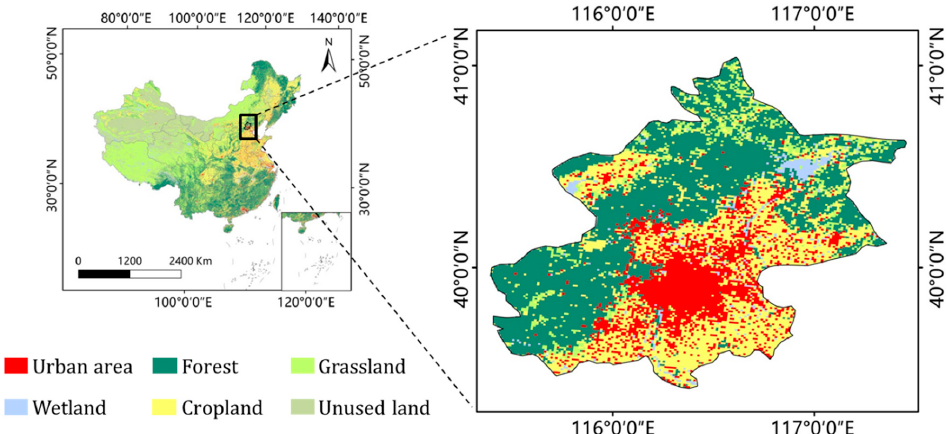
Figure 1. Location of study area and land cover map in Beijing in 2015.